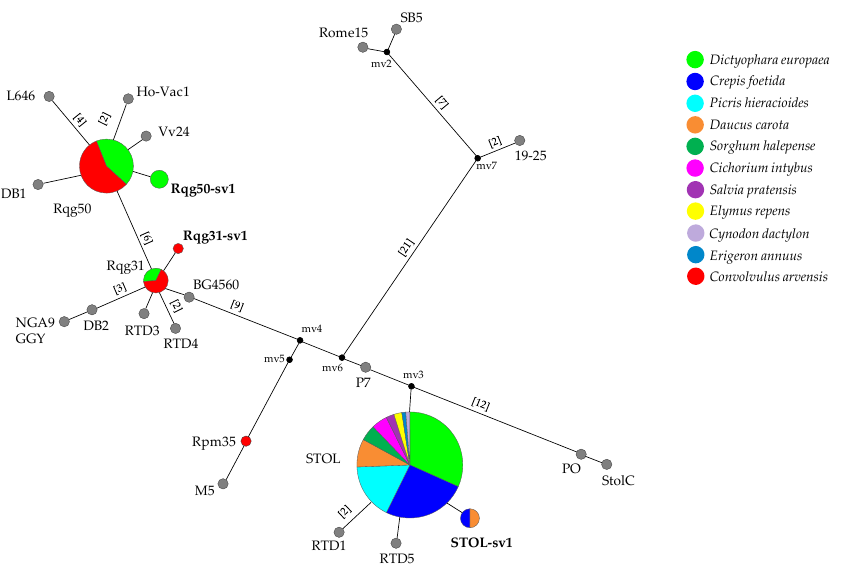
Figure 2. Median-joining network inferred from stamp genotypes of ‘ Candidatus Phytoplasma solani’ strains detected in naturally infected Dictyophara europaea and reservoir plants in this study and those previously identified in the Balkans [11,16,20,35,37,38]. Genotypes PO and StolC originating from France [15] were used for stabilization of the network. Genotypes are represented by circles and paired genotypes are connected by a line. Circle sizes are proportional to the strain frequency found in this study and colors correspond to the associated host as shown in the figure legend. Each line connecting the circles is one mutational difference. For more than one mutational difference between strains, numbers of SNP mutations are presented in brackets; black dot vertices represent median vectors (mv). Gray circles represent reference strains not detected in this study. Strain and vector abbreviations are indicated. Newly detected strains designated in this study are in bold.